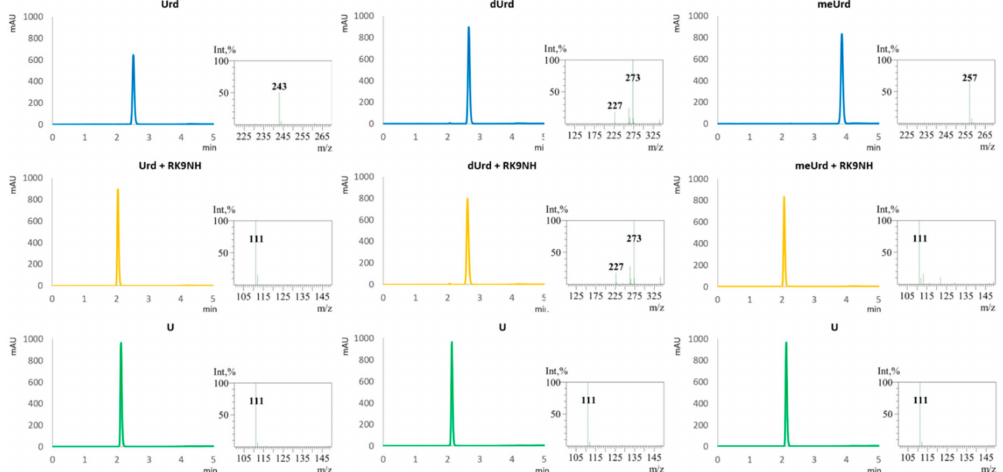
Figure 6. An example of the UV chromatograms ( left ) and MS-spectra corresponding to the peaks ( right ) of substrate standards (blue), nucleoside hydrolase RK9NH enzymatic reaction mixtures (yellow) and product standards (green). The m / z are consistent with [M-H] − detection of molecular ions; the m / z 273 is consistent with [M + HCOOH-H] − of 2 (cid:48) -deoxyuridine. Urd: uridine, dUrd: 2 (cid:48) -deoxyuridine, meUrd: 2 (cid:48) - O